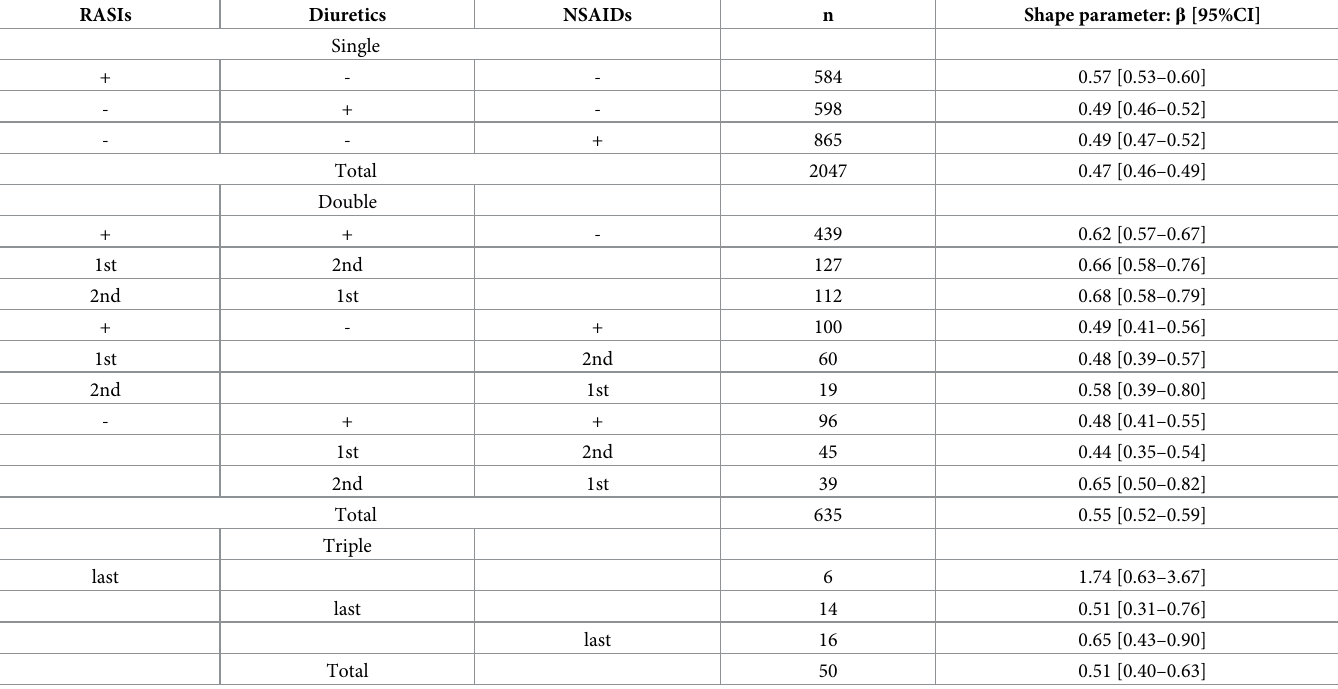
Cases in which multiple TW drugs were started at the same time were excluded. Abbreviations: CI, confidence interval; NSAIDs, nonsteroidal anti-inflammatory drugs; RASIs, renin angiotensin-system